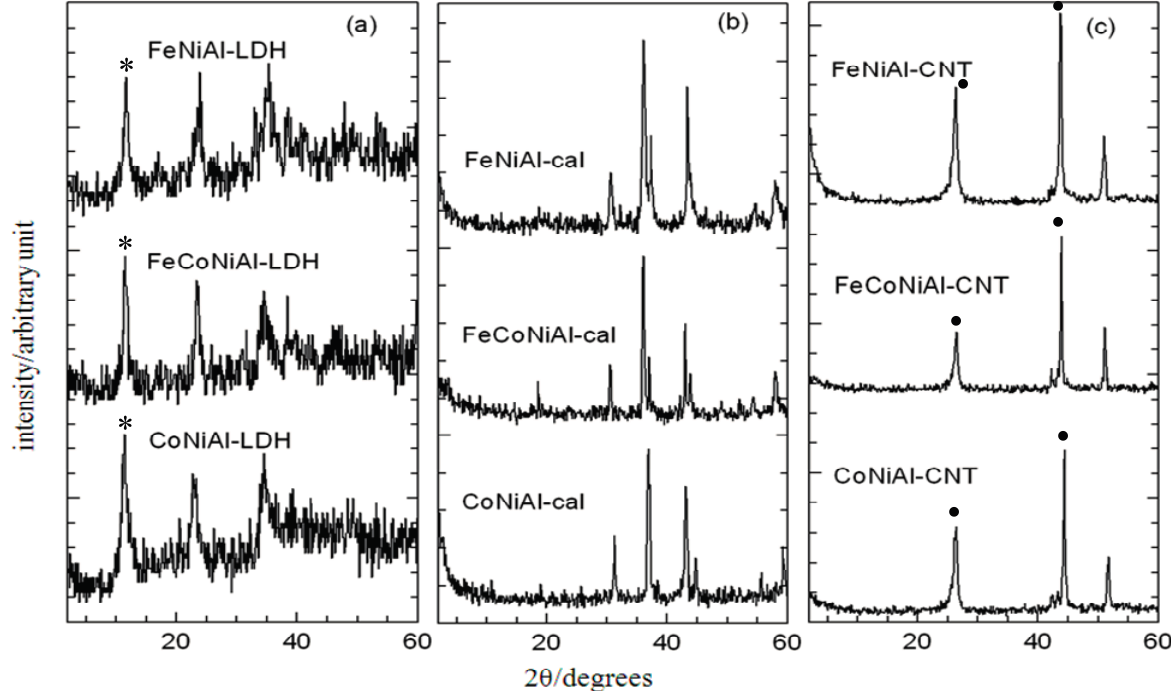
Figure 1. Powder X-ray diffraction (PXRD) patterns of layered double hydroxides (LDH) ( a ) calcined LDH ( b ) and CNT over calcined LDH ( c ). Asterisks (*) show characteristic peaks for LDH at 8.5 Å (003). Dots (•) indicate the characteristic peaks for carbon (26.1 Å, 44.8 Å), indicating the formation of